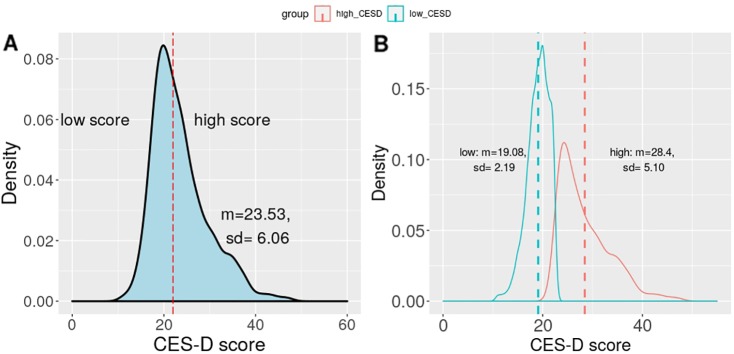
Statistics of the Center for Epidemiologic Studies Depression (CES-D) score. (A) shows the CES-D score in the whole sample (N = 1,628), the red line divides the users into the high and low groups according to their CES-D scores. (B) shows the CES-D scores of the high (N = 776) and low (N = 853) groups, the dotted lines indicate means.